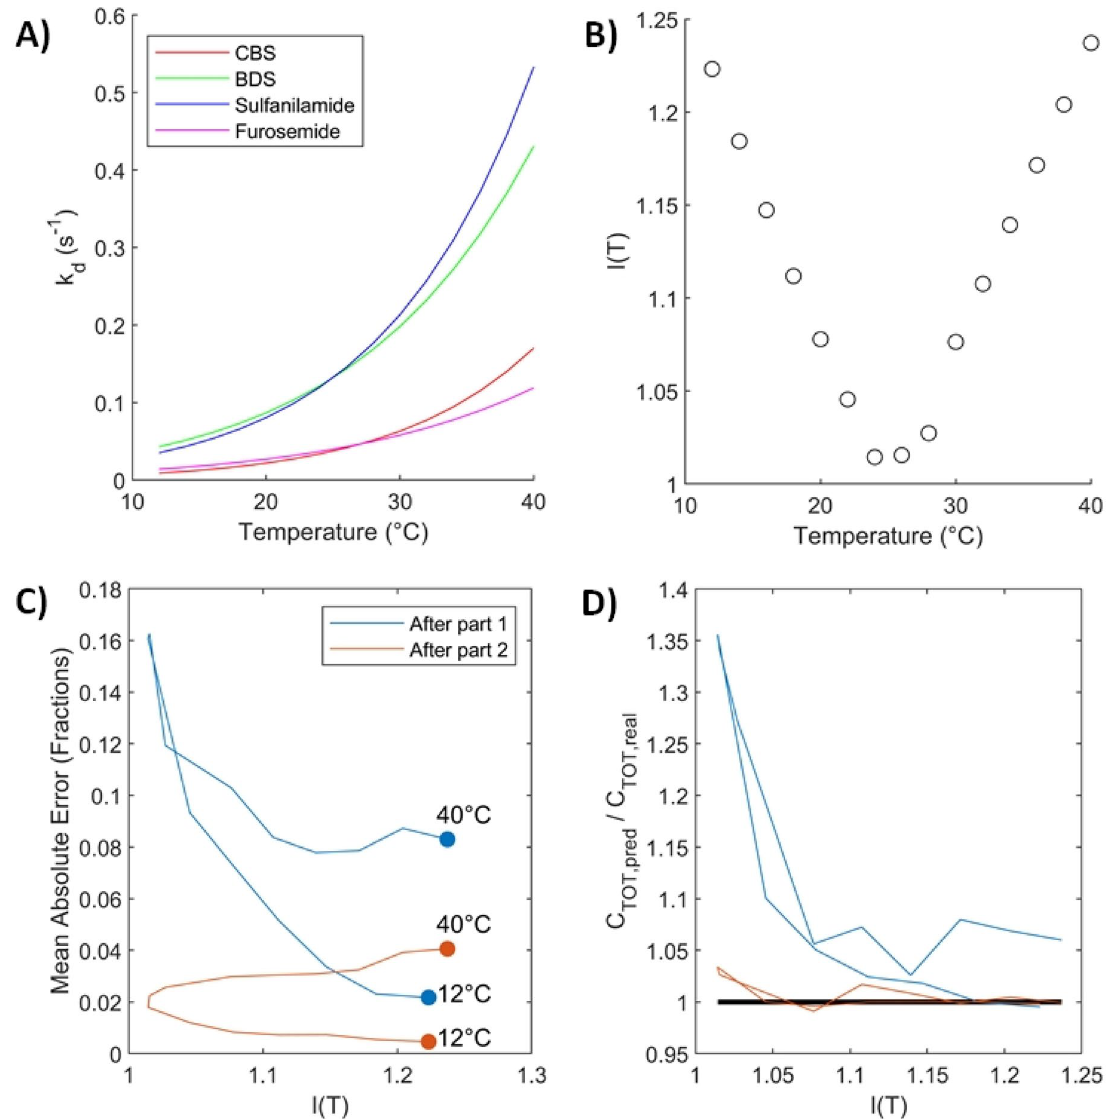
Figure 8. Application of the composition and concentration estimation algorithm to simulated mixtures of the four analytes at 15 temperatures between 12 and 40 °C. ( A ) Dissociation rates of each analyte with respect to temperature. ( B ) Performance indicator with respect to temperature. ( C ) Absolute values of the fraction estimation error averaged over all analytes and mixtures with respect to the indicator after part 1 and part 2 of the algorithm. To help interpretation, corresponding temperatures were added as annotations. ( D ) Ratio of estimated and actual concentrations with respect to the indicator after both parts of the algorithm. The black line corresponds to a perfect estimate (ratio of